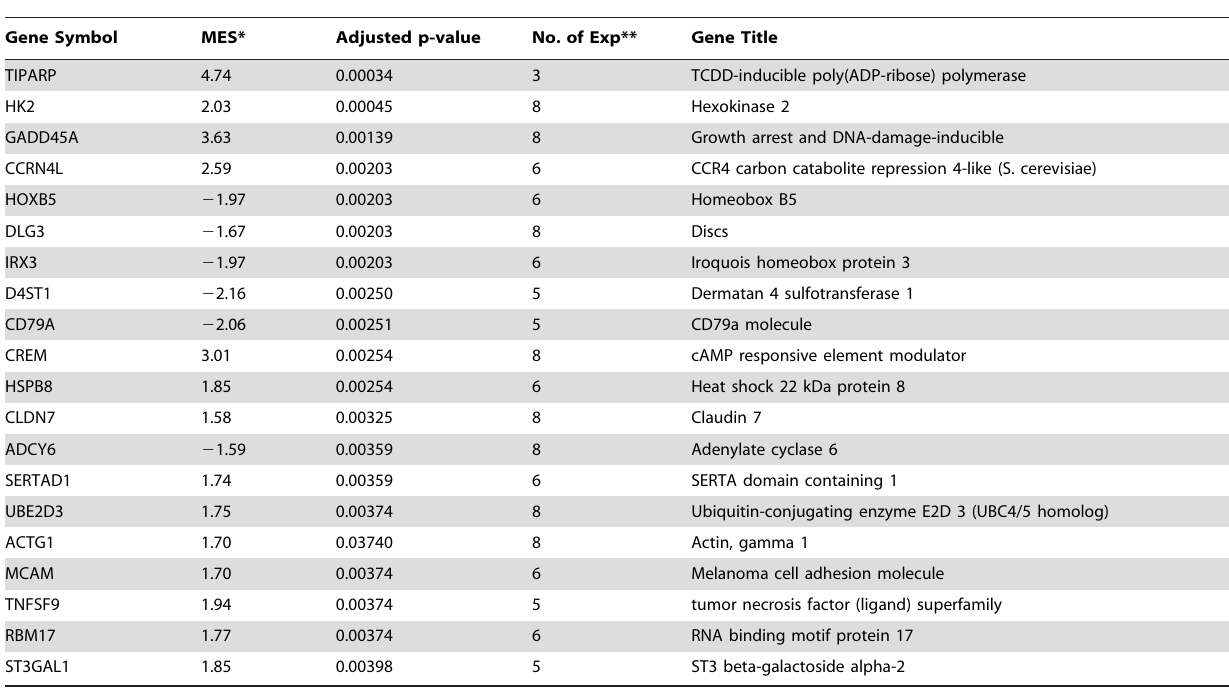
Table 3. Top 20 genes identified by the microarray meta-analysis as differentially expressed in the one-hit model of VILI.